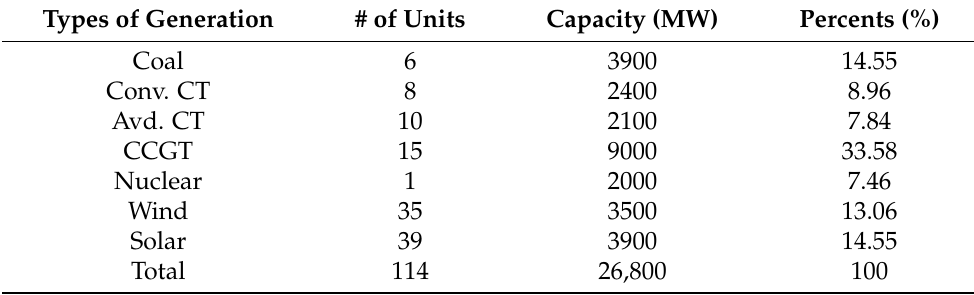
Table 2. Capacity of generating